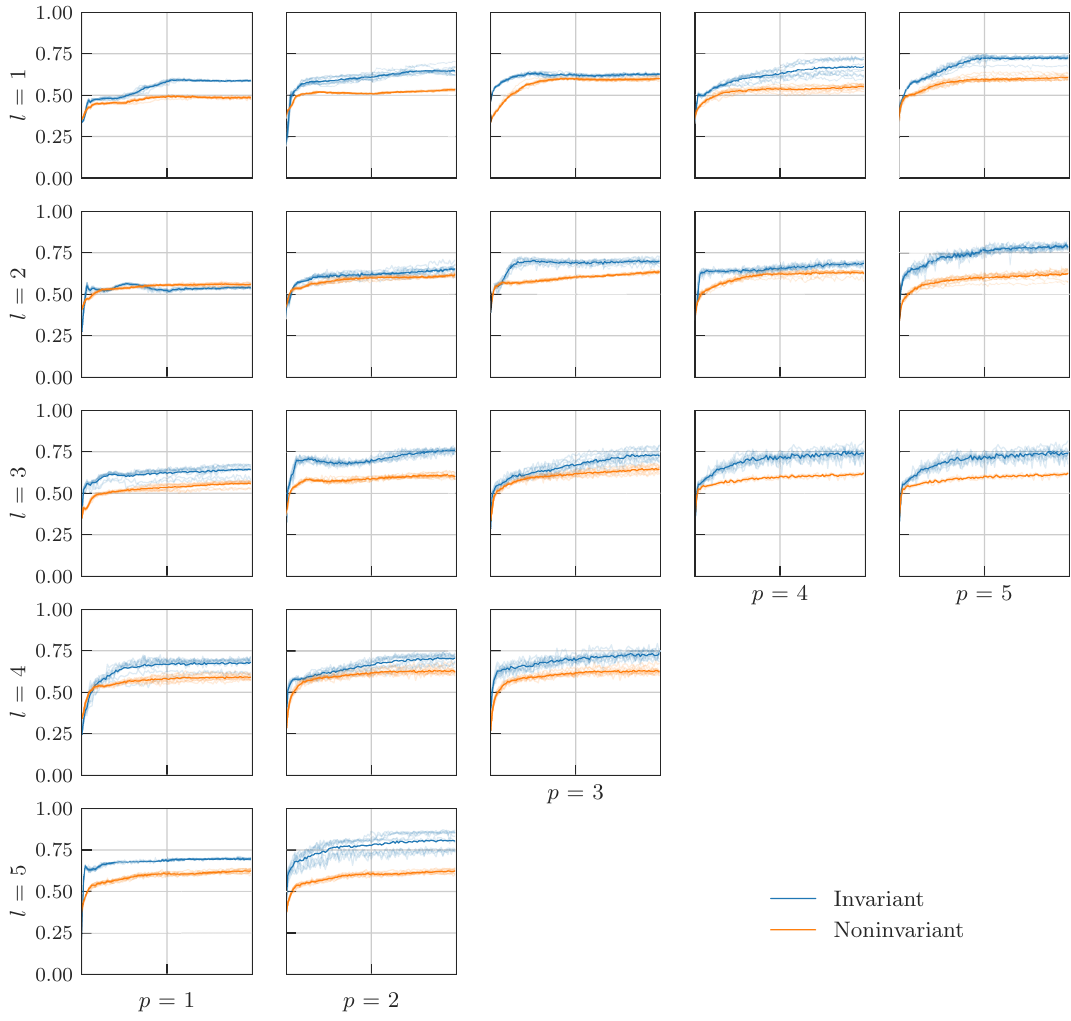
FIG. 14. Plots of the sweep over different values of l and p for the classification of tic-tac-toe games arranged in a grid. Shown on the y axis is the mean test accuracy for the invariant (blue) and noninvariant (orange) models, where the average over the ten runs is plotted in a darker color. Models are composed of l layers, each of which contains one data encoding followed by p times the standard layout “cemoid.” Optimizations are performed for 100 epochs with 30 steps each. At every step, the gradient is computed on 15 games with a total training set size of 15 × 30 = 450. When an epoch ends, the training set is shuffled and the accuracy is evaluated on a test set of 600 random games, which is fixed throughout a simulation. We can see that the invariant model clearly outperforms the noninvariant model. Not simulated are circuits for the values ( 4, 4 ) , ( 4, 5 ) , ( 5, 3 ) , ( 5, 4 ) , and ( 5, 5 ) due to their growing computational demand. Further details can be found in the main